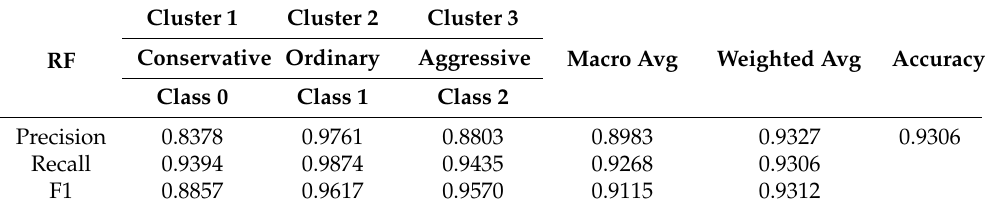
Table 6. Driving style model prediction results.